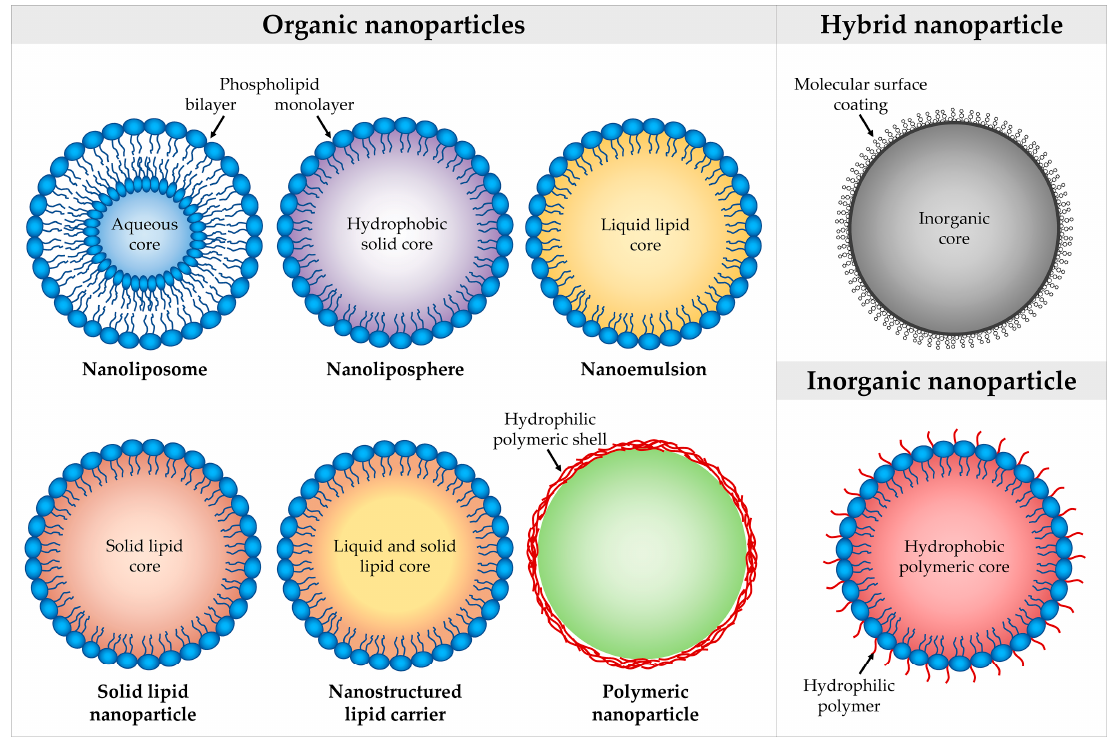
Figure 3. Representative nanocarriers delivering vegetable oil-based nutraceuticals.